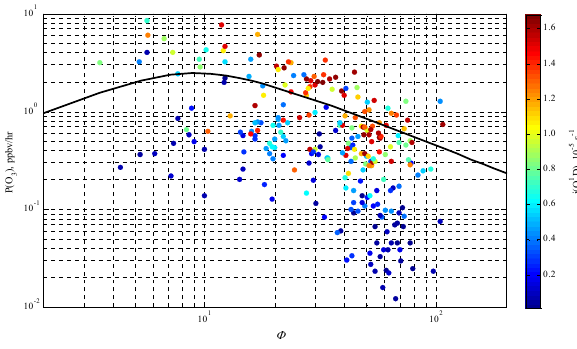
Fig. 3. Dependence of P (O 3 ) on the indicator Φ for daytime 10-min averaged data during 18-21 September, 2003. The color of the dots shows the values of j (O 1 D). The black curve shows the modeled trend of P (O 3 ) with increasing Φ at 1150 JST of 18 September.